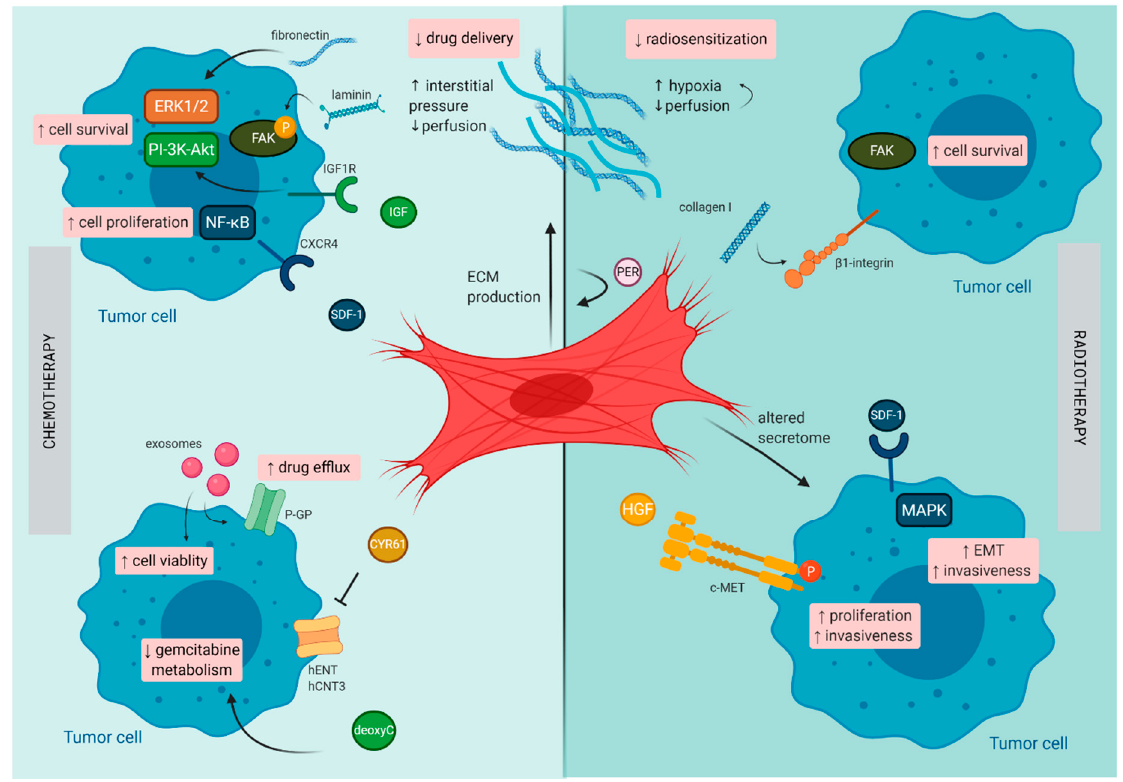
Figure 2. Mechanisms of therapy resistance in pancreatic cancer orchestrated by cancer -associated fibroblasts (CAFs): Schematic illustration on how CAFs diminish the effect of chemotherapy and radiotherapy in pancreatic cancer. c-MET, tyrosine-protein kinase Met CXCR4, C-X-C chemokine receptor type 4; CYR61, cysteine-rich angiogenic inducer 61; deoxyC, deoxycytidine; EMT, epithelial–mesenchymal transition; FAK, focal adhesion kinase; hCNT3, human concentrative nucleoside transporter-3; hENT1, human equilibrative nucleoside transporter-1; HGF, hepatocyte growth factor; IGF, insulin-like growth factor; P, phosphorylated; PER, periostin; P-GP, P-glycoprotein; SDF-1, stromal cell-derived factor-1.